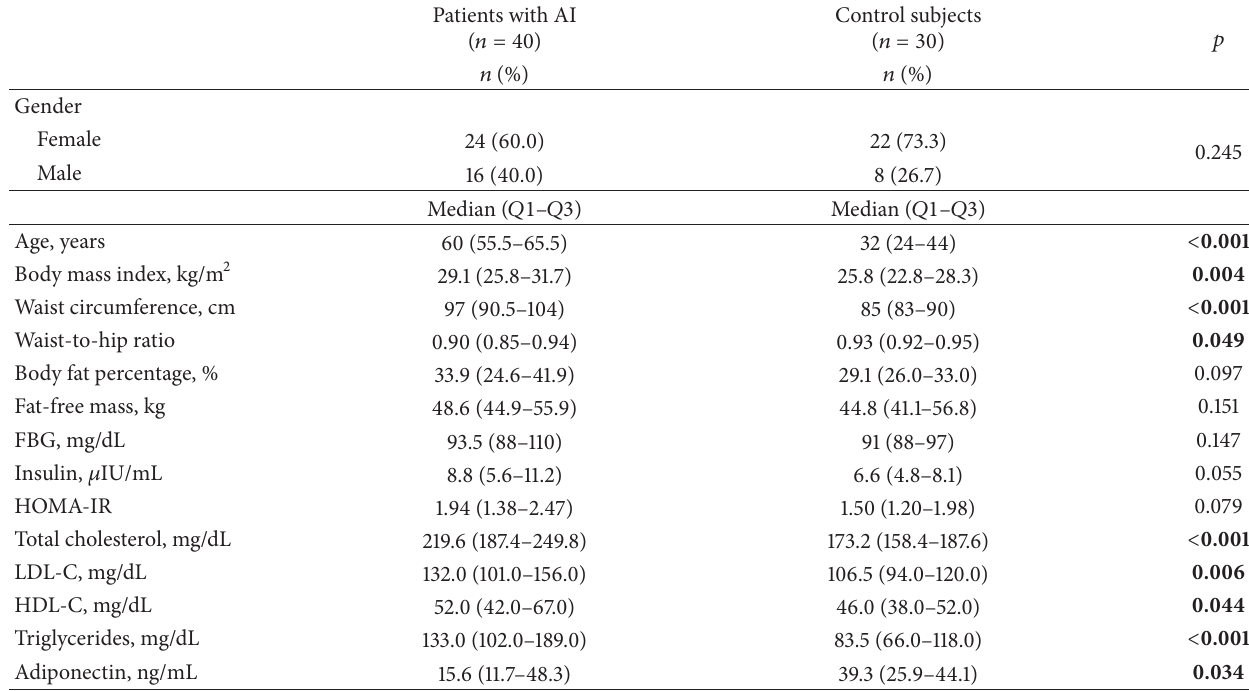
Table 1: Demographic, clinical, and metabolic characteristics of the adrenal incidentaloma patients and control subjects.